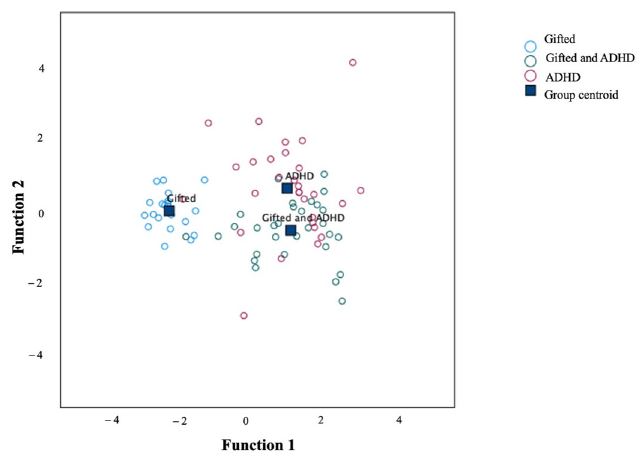
Figure 2. Canonical discriminant functions for the Conners 3 symptom scales. 3.2. Comparison between Respondents in Their Ratings on the Conners 3 Content and Symptom Scales The repeated-measures ANOVA design addressing the third hypothesis compared mothers’, fathers’, and teachers’ responses to the Conners 3 content and symptom scales across the three study groups. Table 4 presents the results of the repeated-measures ANOVA. The results showed significant respondent × group interaction effects specific to the “inattention”, “learning problems”, “executive functioning”, “peer relations”, and “conduct disorder” scales. A simple effects analysis was used to decompose the results of the interaction effects. These analyses showed that there was a significant difference in the